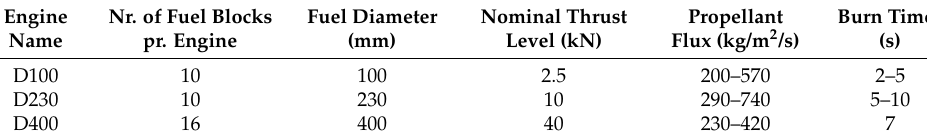
Table 1. Motors used in this research.